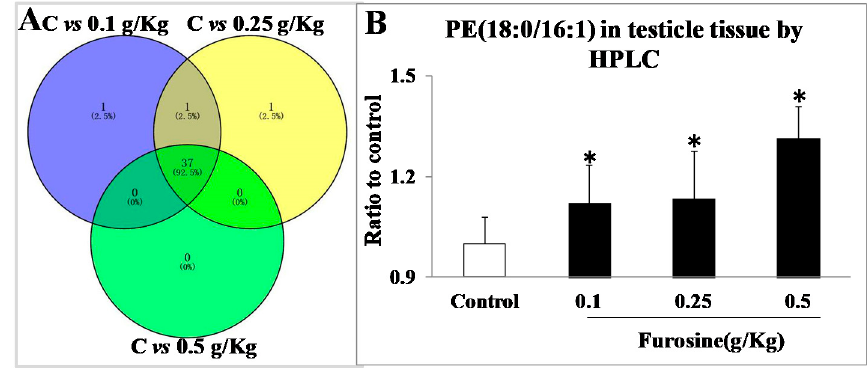
Figure 3. Analysis of lipid metabolites and detection of the special metabolite phosphatidylethanolamine (PE) (18:0/16:1) in testicle tissue by high performance liquid chromatography (HPLC). ( A ) VENN plot. The blue dot stands for metabolites overlapped both in control group and 0.1 g/Kg group, the yellow dot stands for metabolites overlapped both in control group and 0.25 g/Kg group, the green dot stands for metabolites overlapped both in control group and 0.5 g/Kg group. The special metabolites were screened out through overlapping the three areas. ( B ) PE (18:0/16:1) detection in testicle tissue by HPLC. All the data were represented as mean ± SD, n = 8. * Comparing with the control, p ﹤ 0.05.